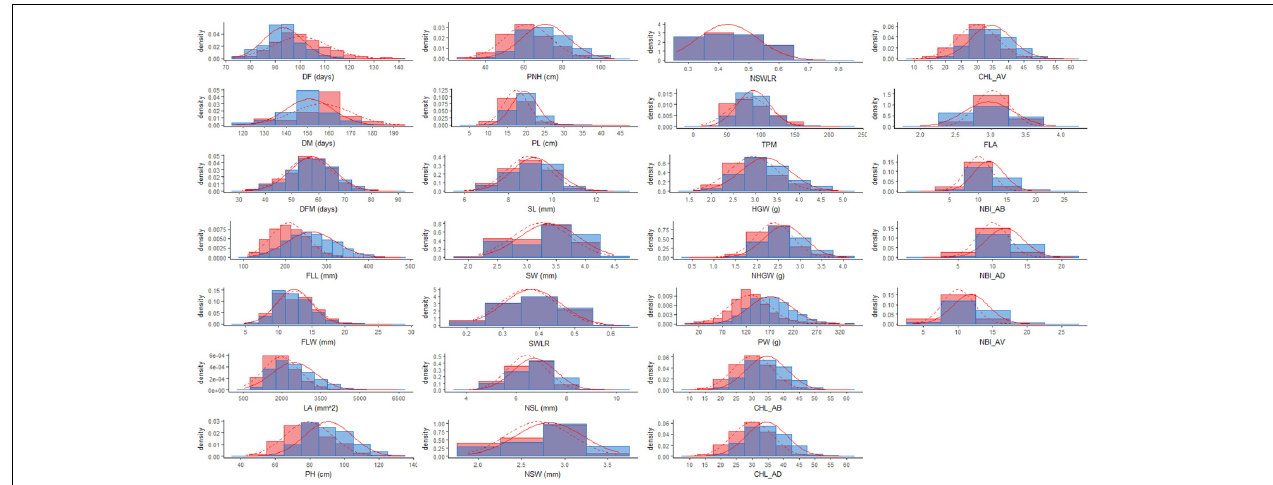
FIGURE 1 | Frequency distribution for all the traits used for the genome-wide association study analyzed in LW (red) and PF (blue) conditions. The normal distributions fitting the LW and PF data were represented with dashed and solid red lines,